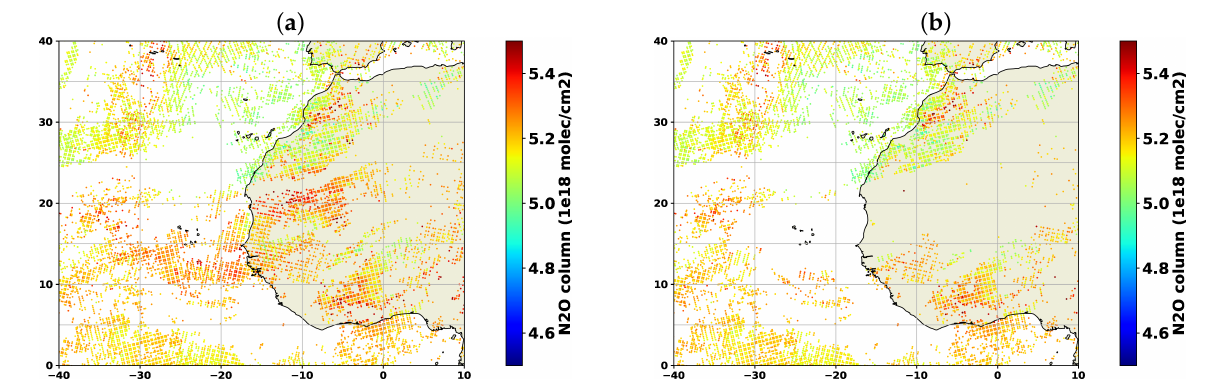
Figure 7. N 2 O partial column along the retrieval vertical range for the 1st of June 2018, ( a ) with the standard quality control and ( b ) with the added filtering to remove dusty scenes.